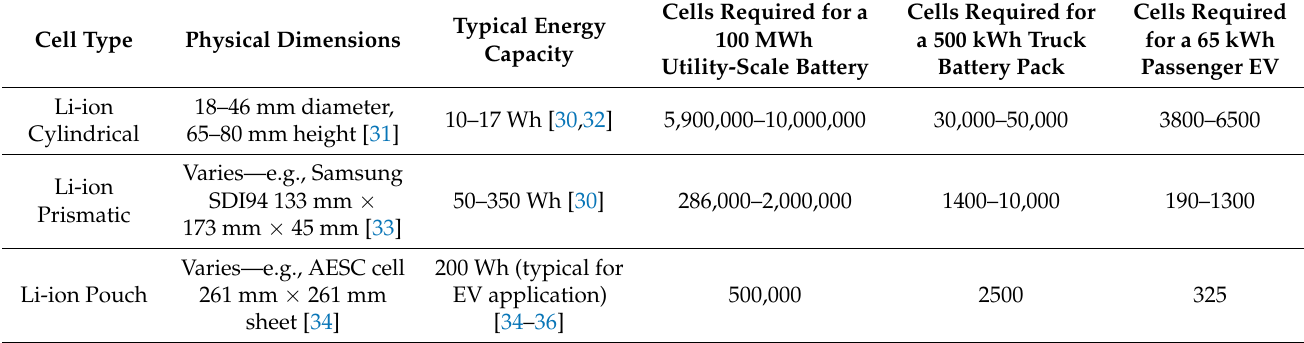
Table 1. Quantitative comparison matrix between battery type and scale of